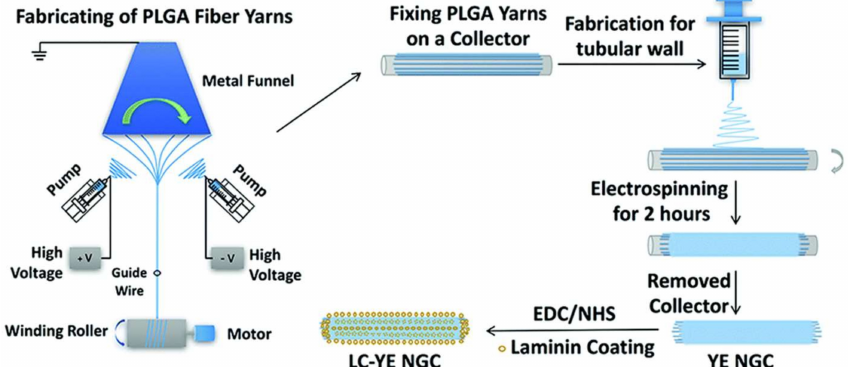
Figure 2. A schematic diagram of the fabrication of the laminin-coated and yarn-encapsulated PLGA (LC-YE-PLGA) nerve guidance conduit (YE NGC: yarn-encapsulated nerve guidance conduit; LC-YE NGC: laminin-coated and yarn-encapsulated nerve guidance conduit) [49]. Reproduced by permission of The Royal Society of Chemistry,